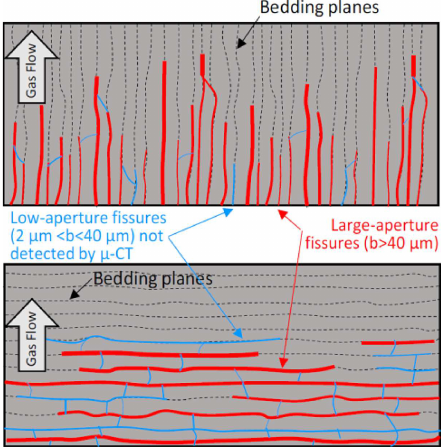
Fig. 2. Schematic representation of expected gas flow at dif- ferent orientations of bedding planes: parallel to flow (top) and orthogonal to flow (bottom). Dashed thin lines represent bed- ding planes. Solid lines depict the volume occupied by gas: apertures larger than 40 µ m and detected by µ -CT (in red); and apertures between 2 and 40 µ m detected by MIP but not by µ -CT (in blue)